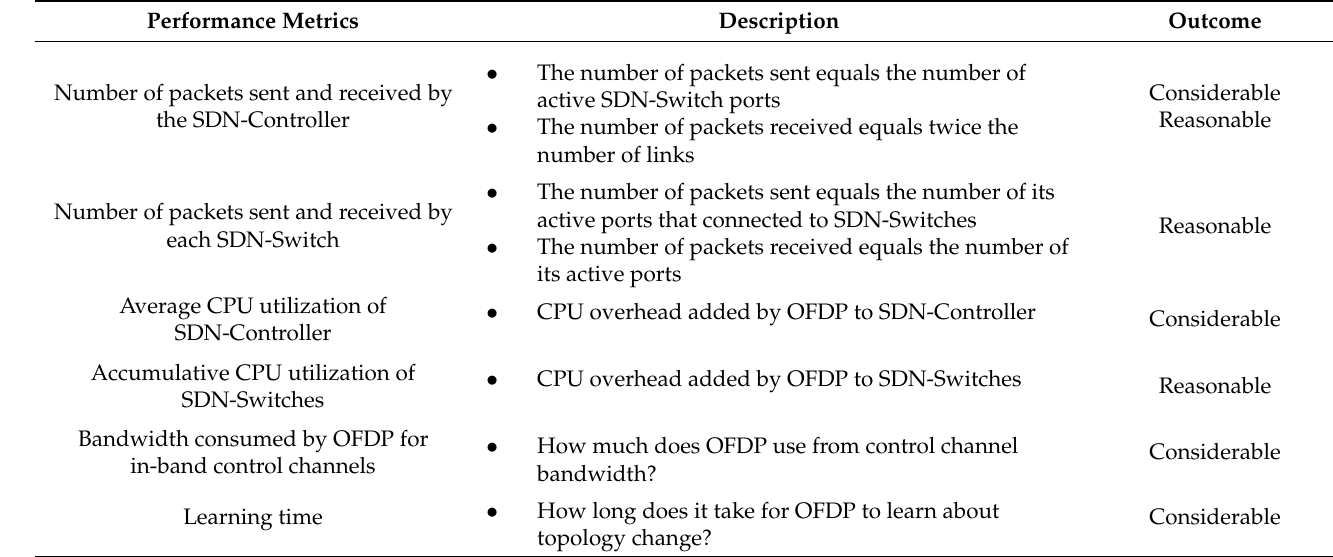
Table 3. OFDP performance in large and dynamic